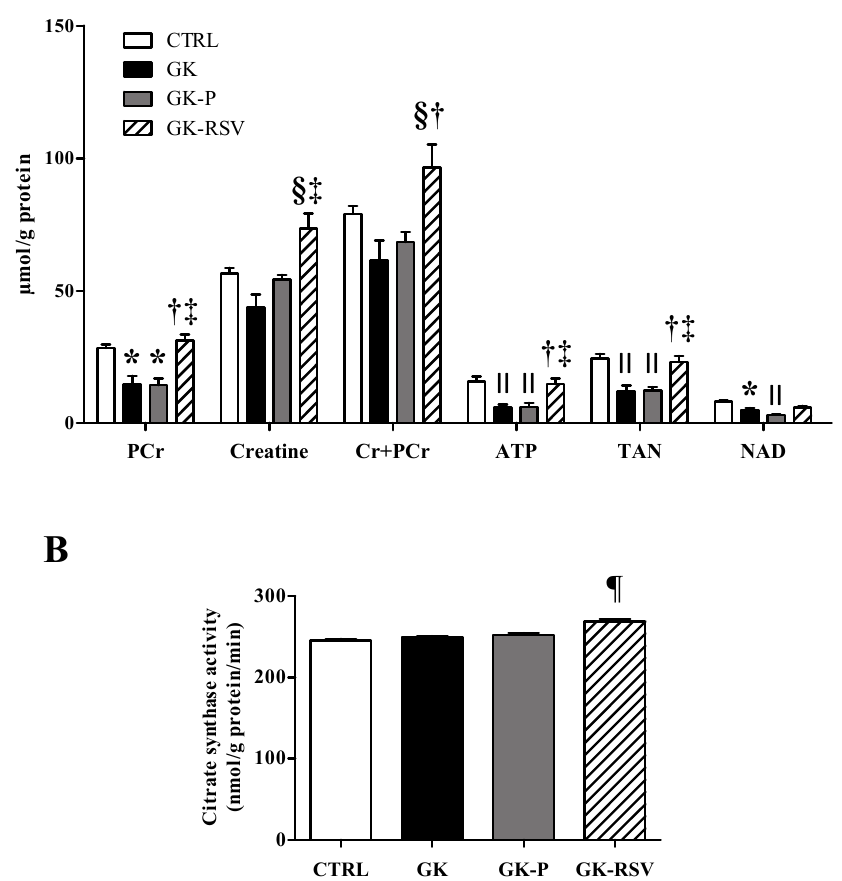
Figure 3. Total pool of phosphocreatine, creatine, PCr + Cr, ATP, total adenine nucleotides (TAN) ( A ) and citrate synthase activity ( B ) in rat hearts. Data are expressed as means ± SEM and one-way ANOVA was used to compare the groups. * p < 0.05 vs. CTRL, † p < 0.01 vs. GK, ‡ p < 0.05 vs. GK-P, § p < 0.001 vs. GK; II p < 0.01 vs. CTRL; and ¶ p < 0.0001 vs. CTRL, GK, and